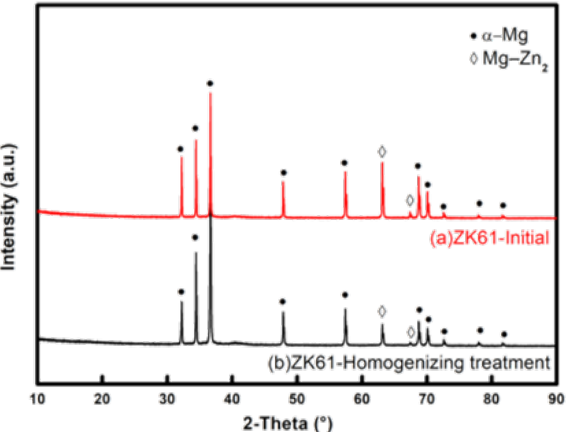
Figure 2. X-ray diffraction pattern of ZK61 magnesium alloy before ( a ) and after ( b ) homogenization treatment.